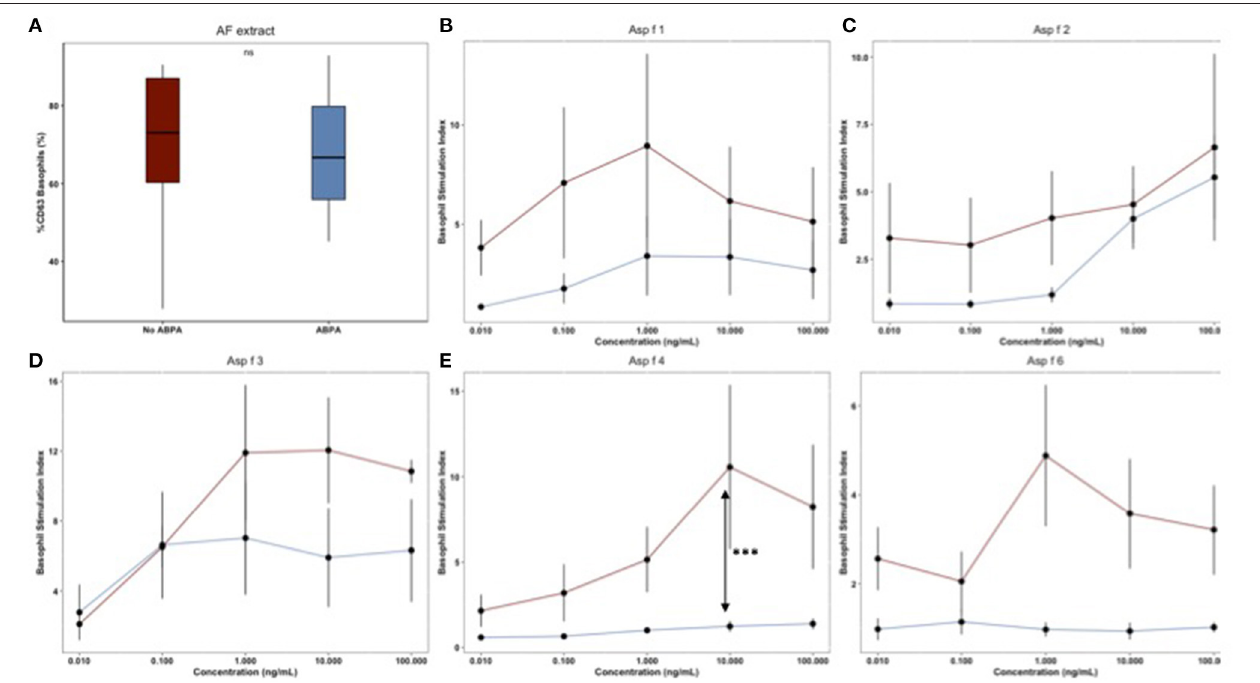
FIGURE 3 | (A–E) Mean BAT responses for AF molecular components: Asp f 1, Asp f 2, Asp f 3, Asp f 4, Asp f 6. Mean (SD) responses for AF extract and each AF molecular component’s concentration were calculated for ABPA ( n = 6, red lines) and AF sensitized ( n = 6, blue lines) patients. Significant difference was calculated at each point.